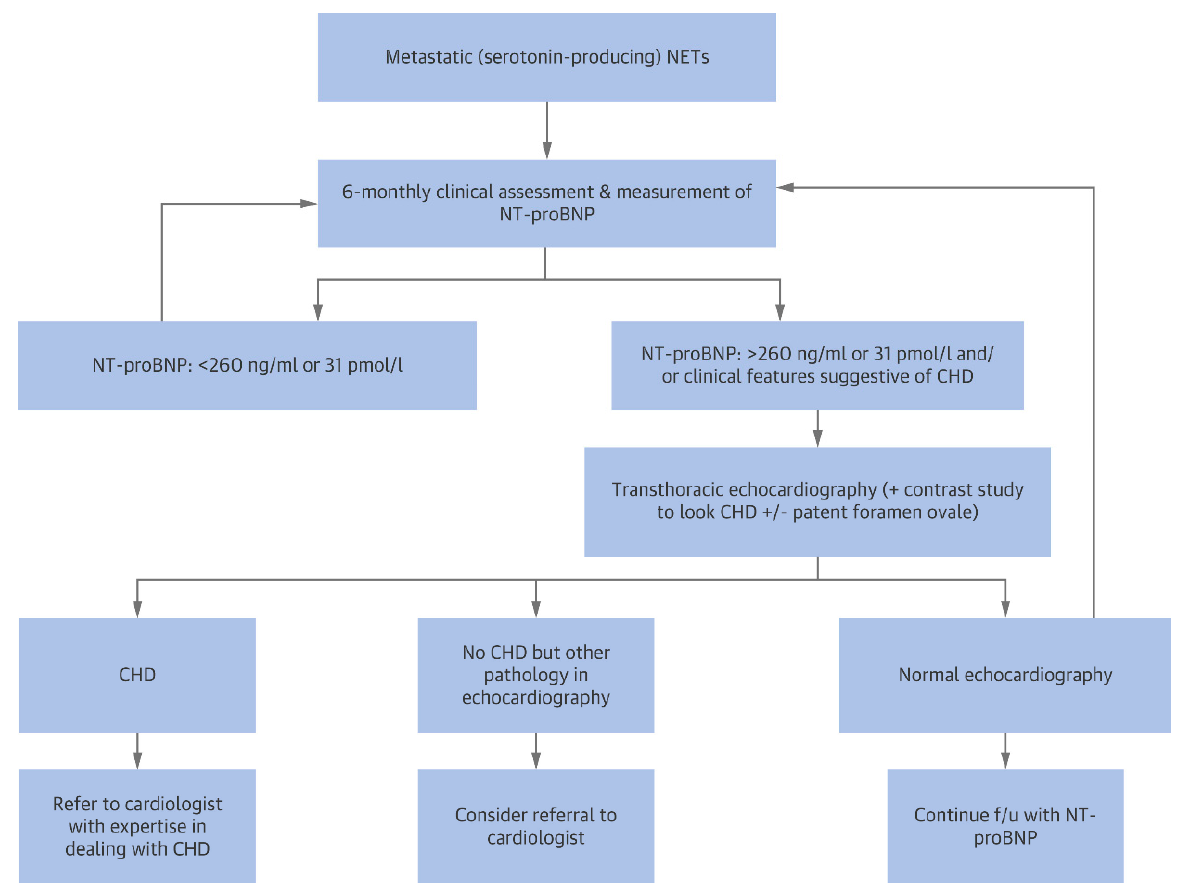
Figure 13. Screening algorithm for carcinoid heart disease (CHD) based on NT-proBNP values [89].